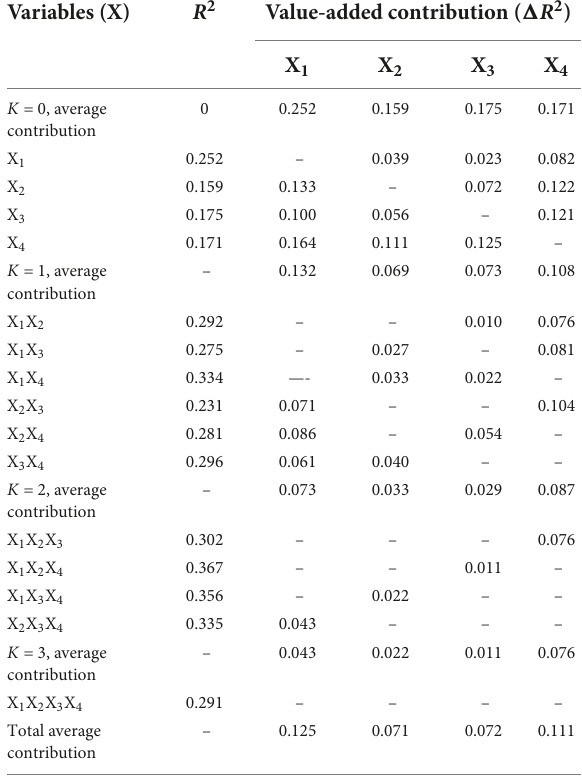
TABLE 1 Demographic and relevant variables differences in scores of psychological distress.